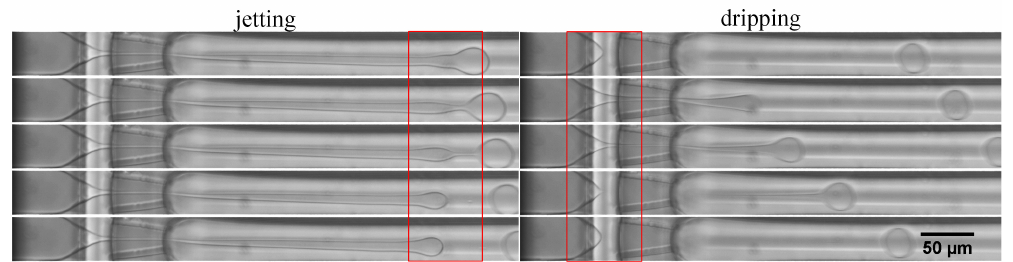
Figure 6. The trimethylolpropane ethoxylate triacrylate (ETPTA) droplet formation process through jetting and dripping mode. The bulk concentration of surfactant is 5 vol